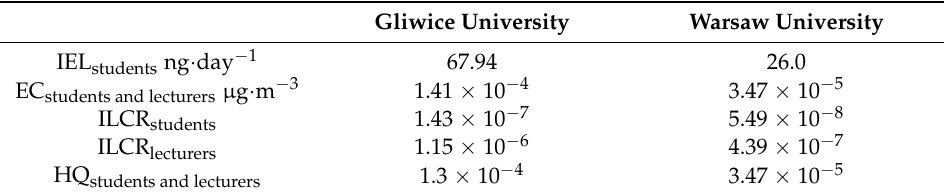
Table 4. The inhalation doses of PM 1 -bound Hg p and PAHs and the related non-carcinogenic and carcinogenic health risks at Polish